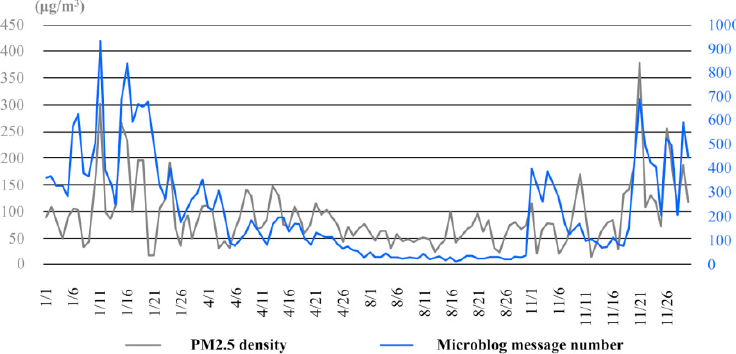
Figure 3. The variation curves of PM2.5 density and microblog message number in the four sample months.